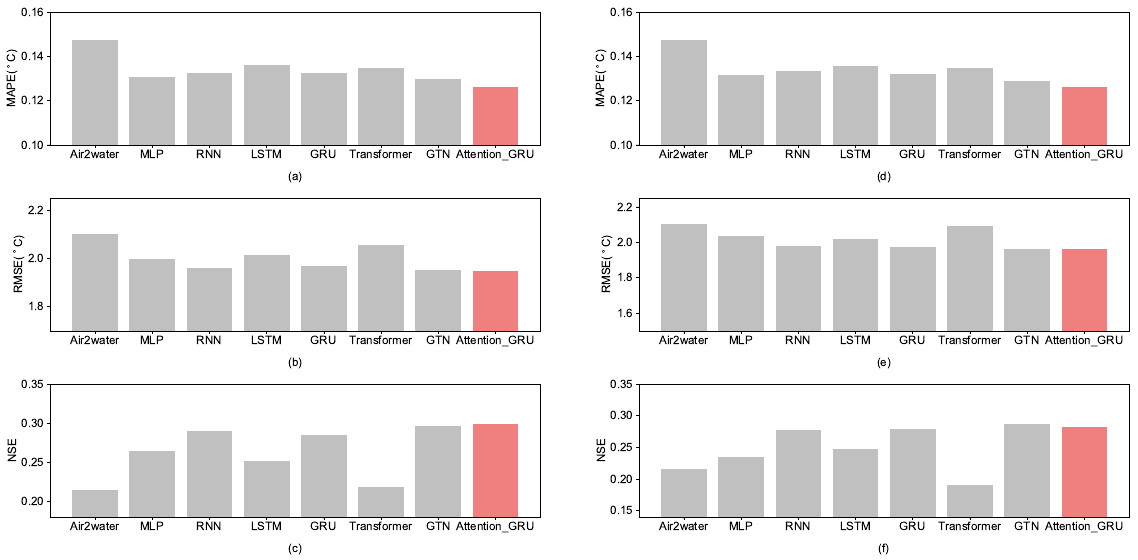
Figure 5. The comparison of the deep learning model with Air2water. ( a – c ) are the results of evaluation indexes under linear interpolation method, respectively; ( d – f ) are the results of evaluation indexes under Cubic spline interpolation method, respectively. The red bar represents the results of the proposed model, and the gray bars represent the results of other comparative